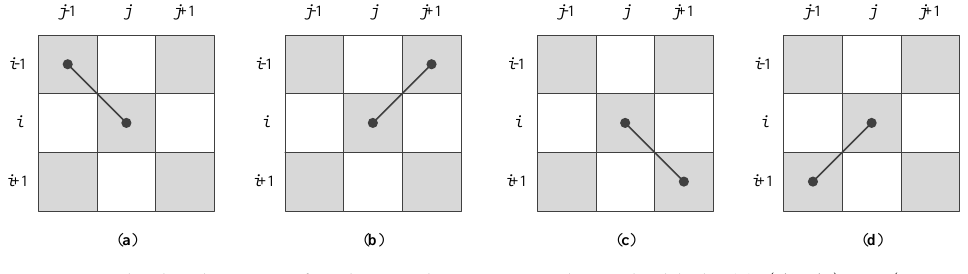
Figure 3. The local context for the pixel x i , j ∈ x to be embedded: ( a ) ( dx , dy ) = ( − 1, − 1 ) , ( b ) ( dx , dy ) = ( − 1,1 ) , ( c ) ( dx , dy ) = ( 1,1 ) , ( d ) ( dx , dy ) = ( 1, − 1 ) . Namely, four pixels x i − 1, j − 1 , x i − 1, j + 1 , x i + 1, j + 1 and x i + 1, j − 1 constitute the local context of x i , j